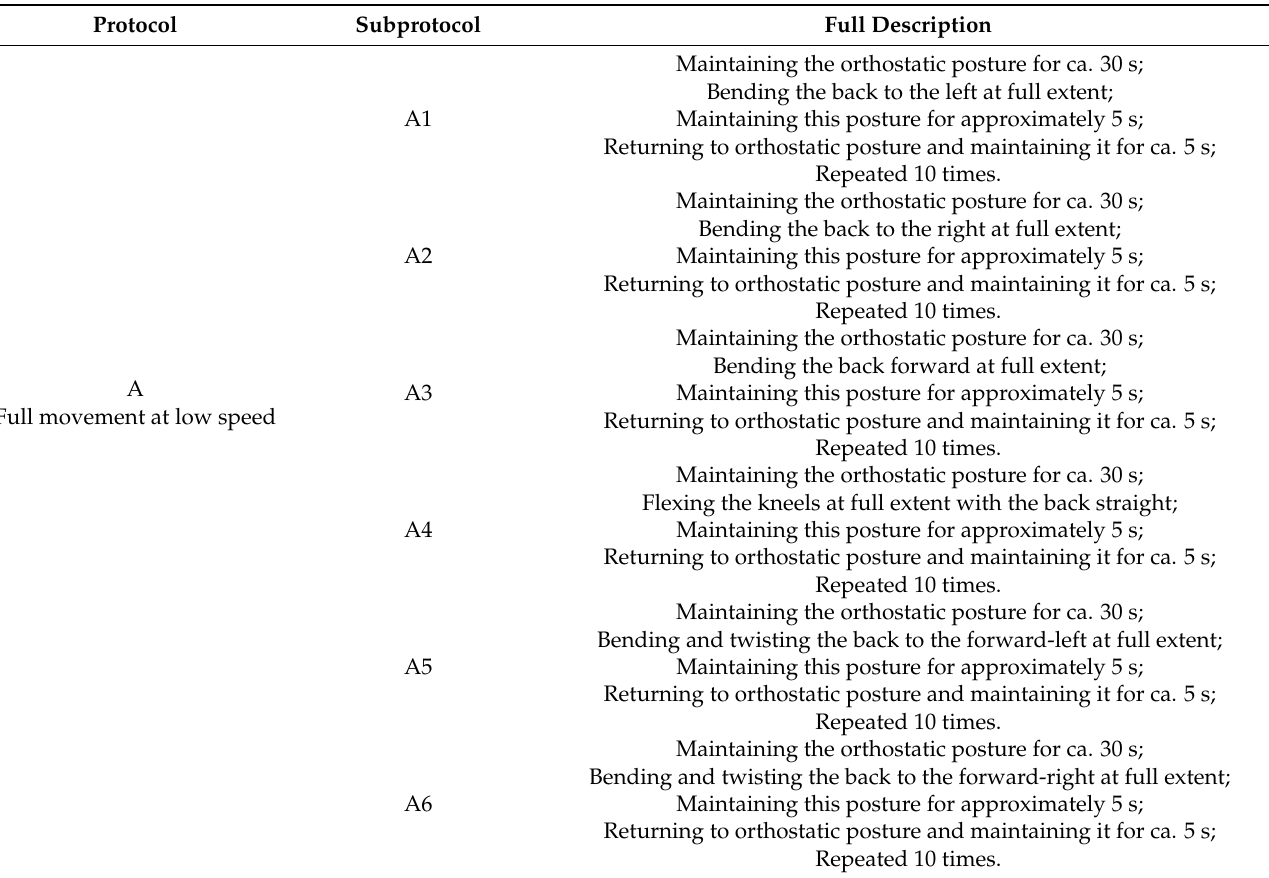
Table A1. Movement and posture change protocol used in this